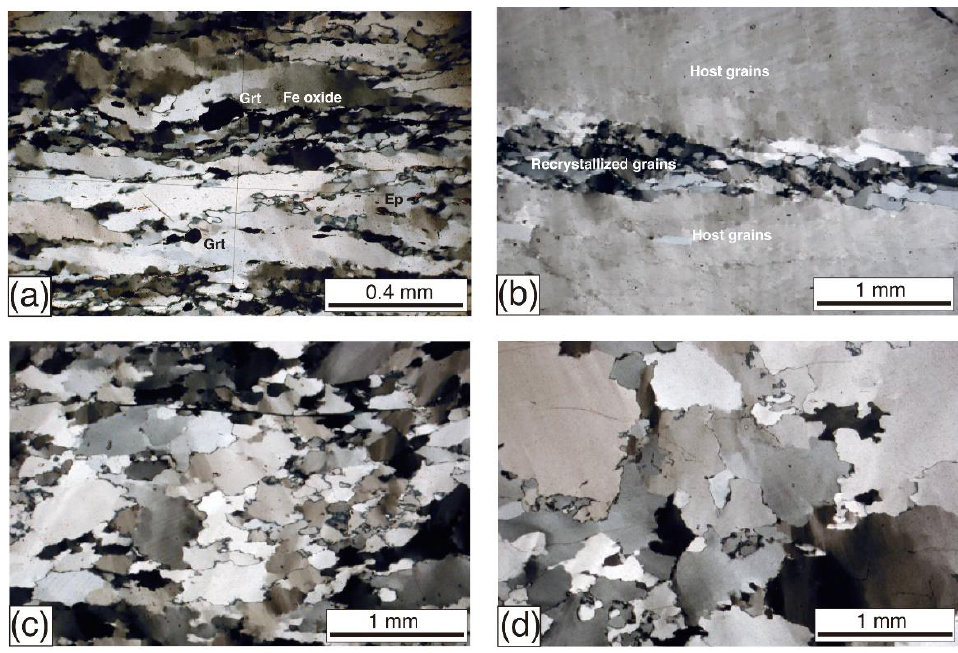
Figure 4. Microphotographs (crossed polarized light) showing microstructures in recrystallized quartz grains. ( a ) Quartz schist from the garnet zone of the LSL. Recrystallized quartz veins from the ( b ) garnet zone (0152504) of the LSL, ( c ) albite-biotite zone of the LSL (0152506), and ( d ) albite- biotite zone of the USL (0152510). Note that dynamic recrystallization occurs by subgrain rotation in ( a ) shown by serrated boundaries of recrystallized grains and subgrain formation. Note dynamic recrystallization is not complete in ( b ), suggesting subgrain rotation recrystallization, while it occurs by grain boundary migration in ( c ) and ( d ) shown by lobate boundaries of recrystallized grains and complete dynamic recrystallization. Note also that the recrystallized quartz grain size in the albite-biotite zone is larger in the ( d ) USL than in ( c ) LSL. Sample localities are shown in Figure 2. Grt, garnet; Ep,